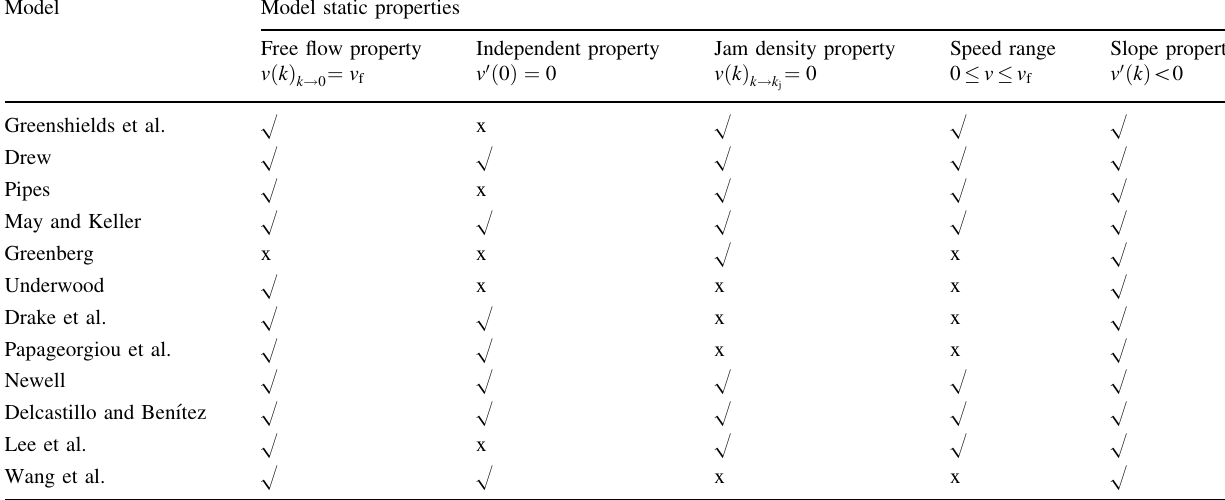
Table 5 Validation of static properties